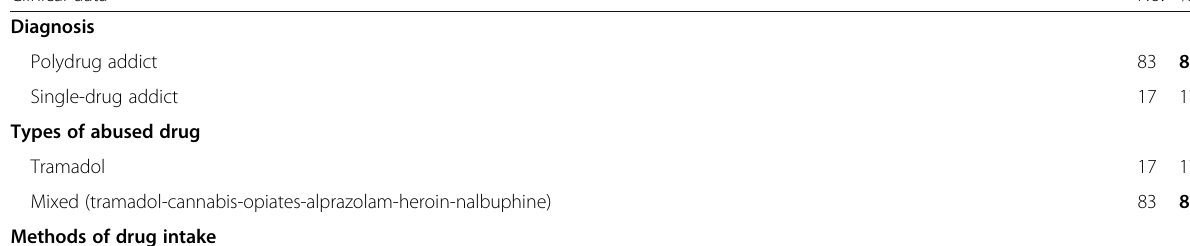
Table 2 Clinical characteristics of the SUD patients ( n = 100) Clinical